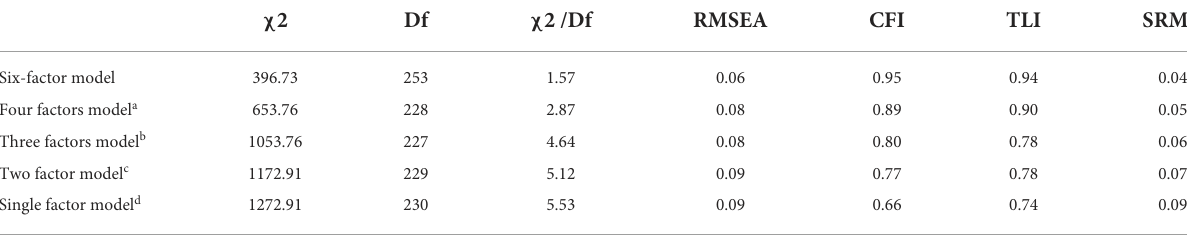
TABLE 1 Results of confirmatory factor analysis.